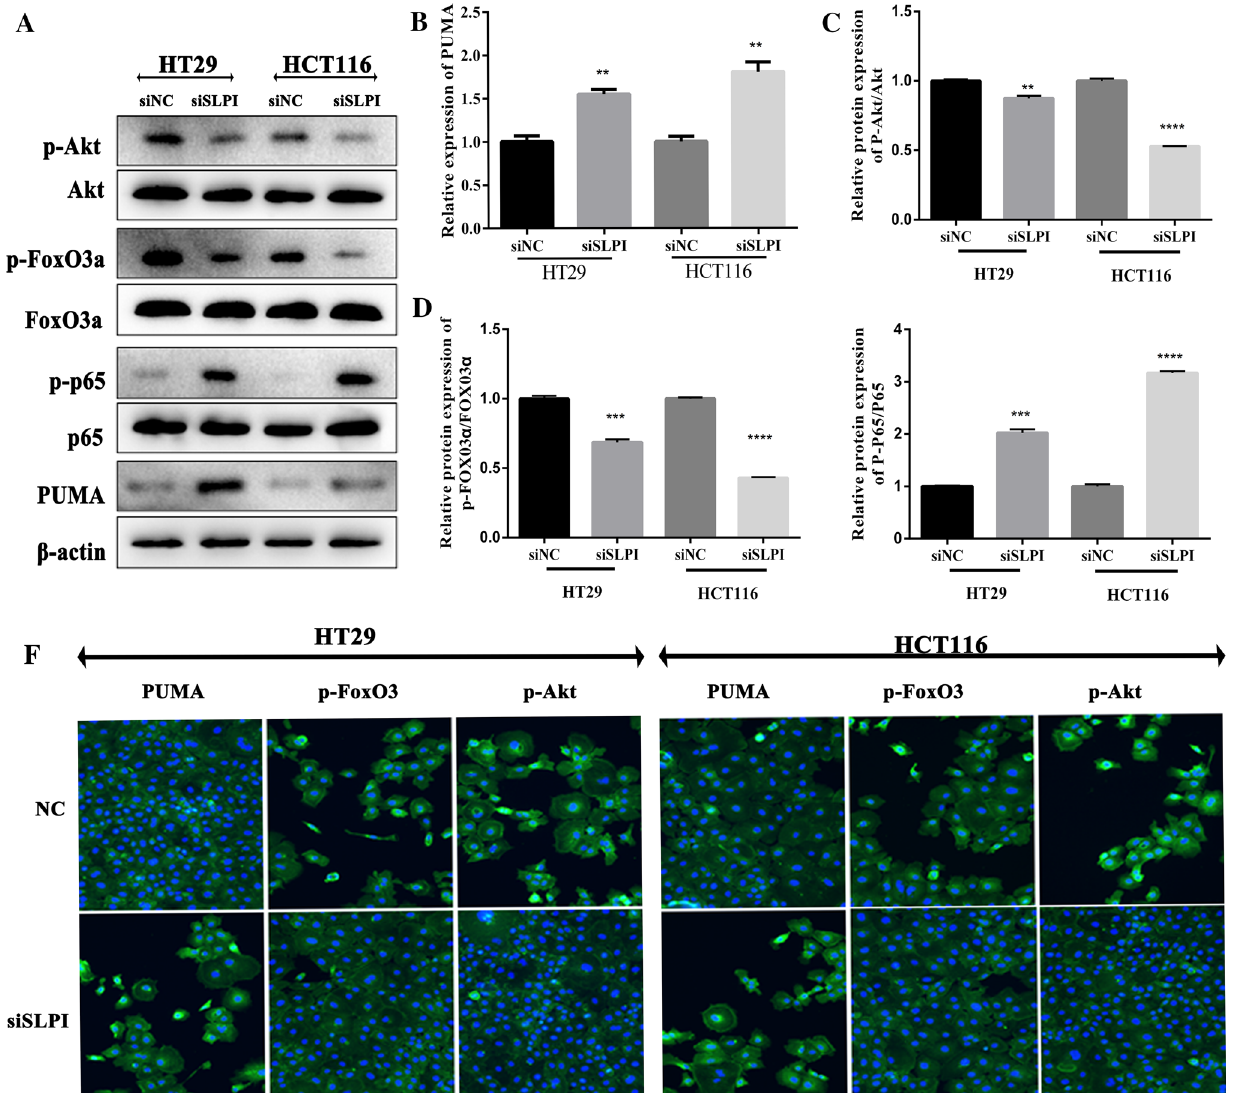
Fig. 2 Inhibition of SLPI promotes PUMA expression through Akt related signaling pathway. A Western blot displaying how inhibition of SLPI decreased phosphorylation of both Akt p-fox3a proteins, while the phosphorylation of p65 was greatly increased. Scale bar represen- tation of the protein expressions of Akt, FoxO3 and p65, respectively ( B – E ). Immunofluorescence results depicted the decreased levels of p-Akt and p-fox3a and upgraded levels of p-p65 in response to SLPI inhibition ( F ). *p < 0.05; ***p < 0.1, and ****p <